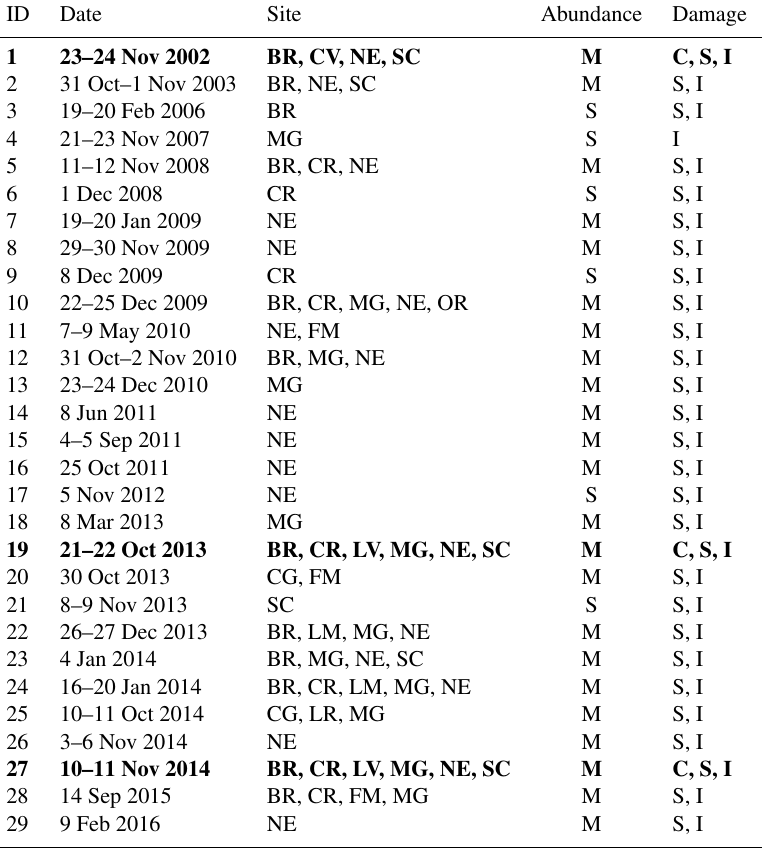
Table 1. Rainfall events that have triggered – mostly shallow – landslides in the Entella River catchment in the 15-year period 2002–2016. In bold are the three events discussed in the paper. Sites: BR – Borzonasca; CG – Cicagna; CR – Carasco; CV – Chiavari; FM – Favale di Fig. 1 for location of the sites. Abundance of landslides: S – single landslide; M – multiple landslides. Damaged element: B – building; I – infrastructure; R – road; S – structure; C –